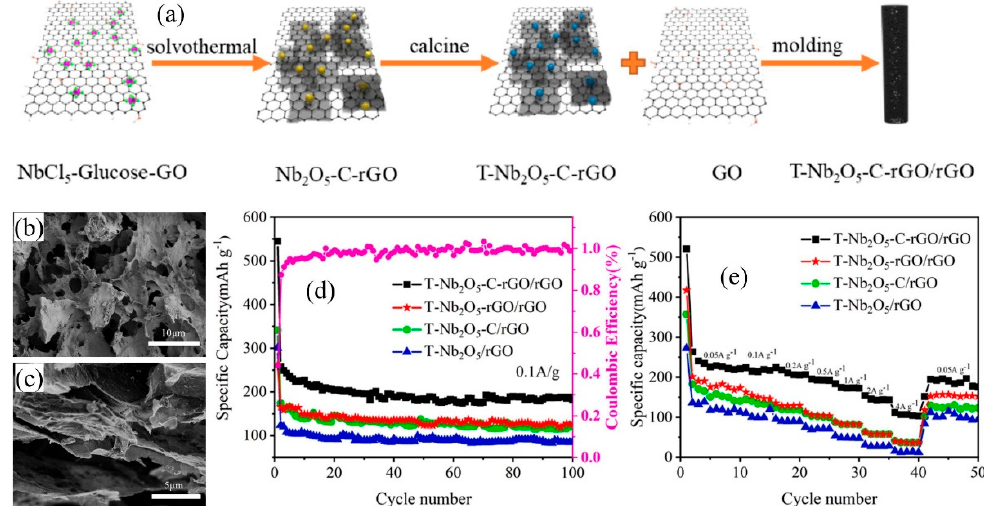
Figure 5. ( a ) Schematic of the fabrication procedure for T-Nb 2 O 5 -C-rGO/rGO fiber anode. Cross- sectional scanning electron microscopy images of T-Nb 2 O 5 -C-rGO/rGO fiber ( b ) before pressing and ( c ) after pressing. ( d ) Cycling performance and ( e ) rate performance of samples. Reproduced with permission from Ref. [62] Copyright 2022 Elsevier.